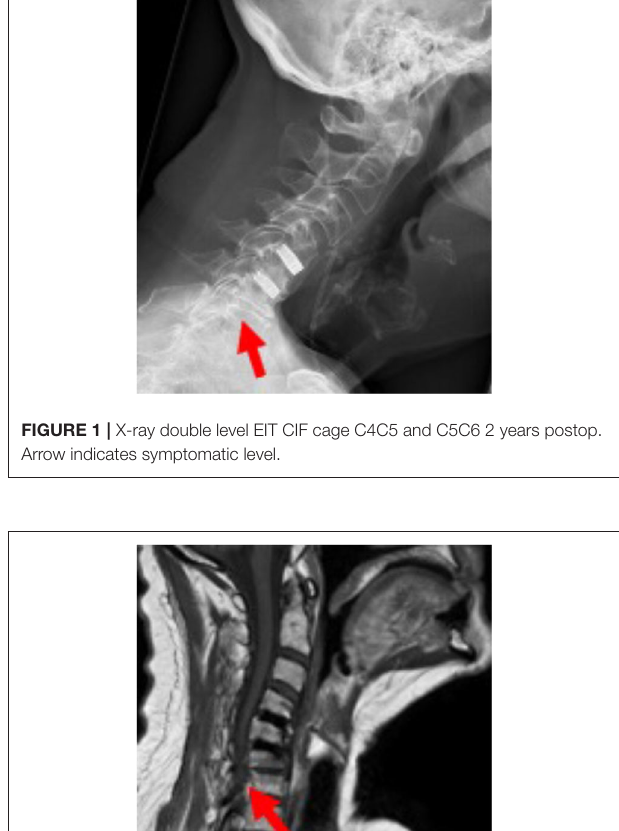
The EIT Cellular Titanium R (cid:13) cervical cage at the level C5/C6 was extracted during revision surgery and was immediately stored in formaldehyde 4% buffer solution ( Figure 3B